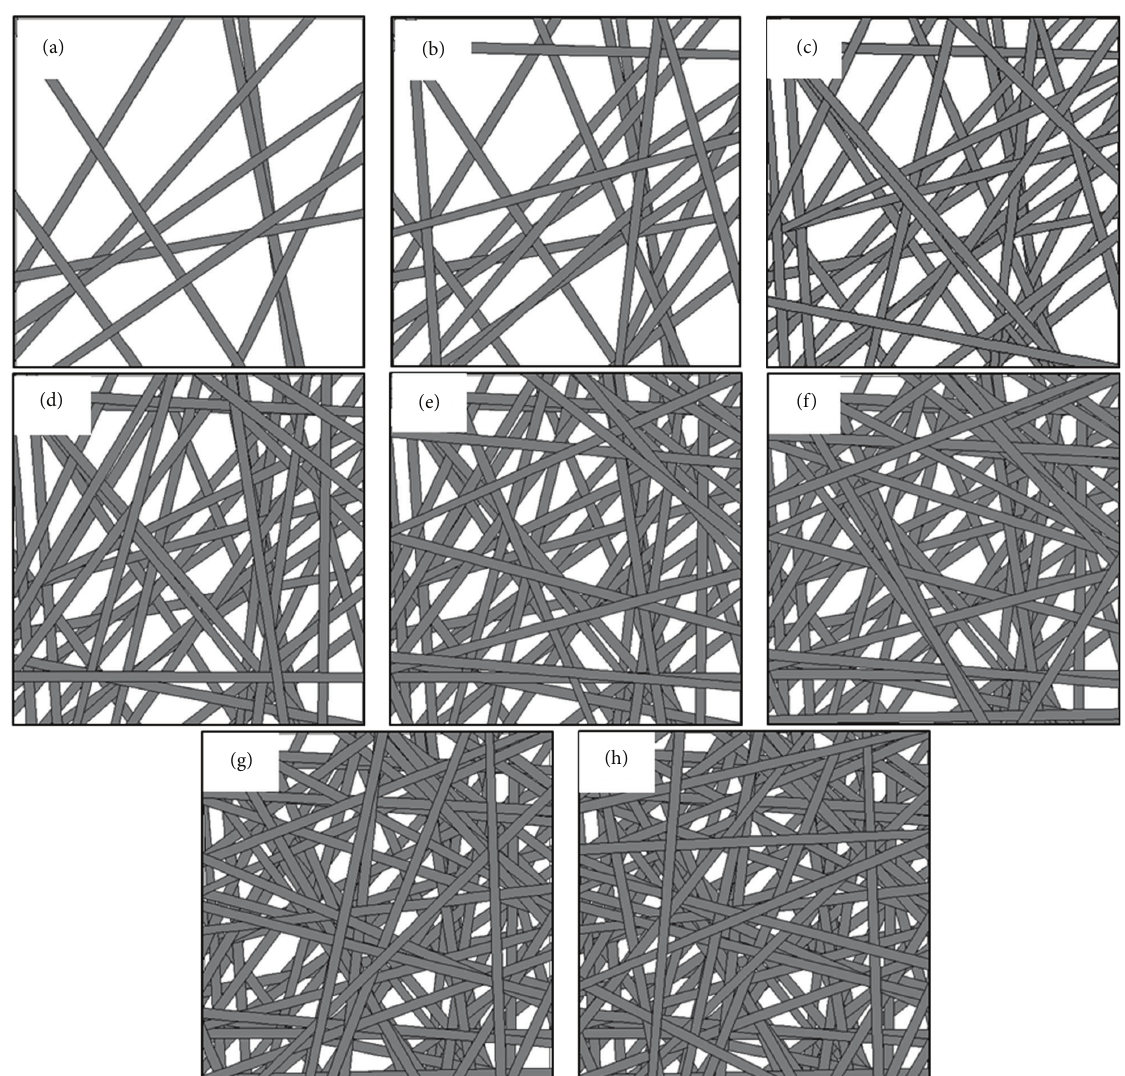
Figure 2: The simulated structures of nanofibers with monodisperse size of 𝑑 𝑓 when the number density of fibers is (a) 0.1, (b) 0.2, (c) 0.3, (d) 0.4, (e) 0.5, (f) 0.6, (g) 0.7, and (h)